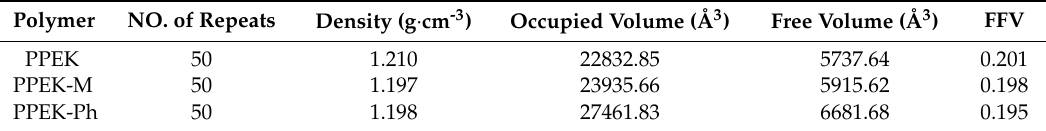
Figure 3. The amorphous cells of polymers after being simulated by MS 2017R2: ( a ) PPEK, ( b ) PPEK-M, and ( c ) PPEK-Ph. Table 2. The parameters of amorphous cell after being analyzed.